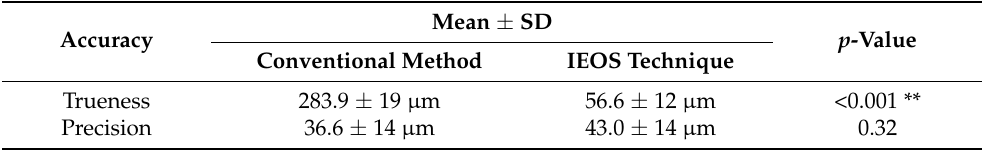
Figure 8. ( A ) Trueness: STL data of provisional and definitive restorations were superimposed by software. ( B ) Precision: STL data of each definitive restoration were superimposed on the software.